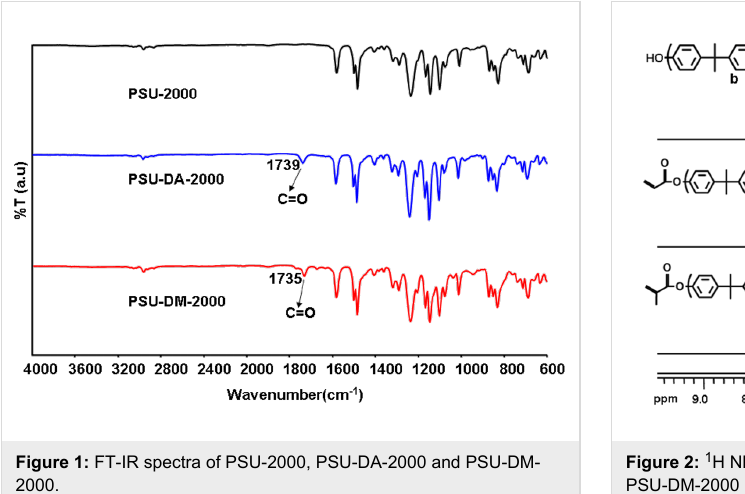
Figure 2: 1 H NMR spectra of PSU-2000 (a), PSU-DA-2000 (b) and PSU-DM-2000 (c) in CDCl 3